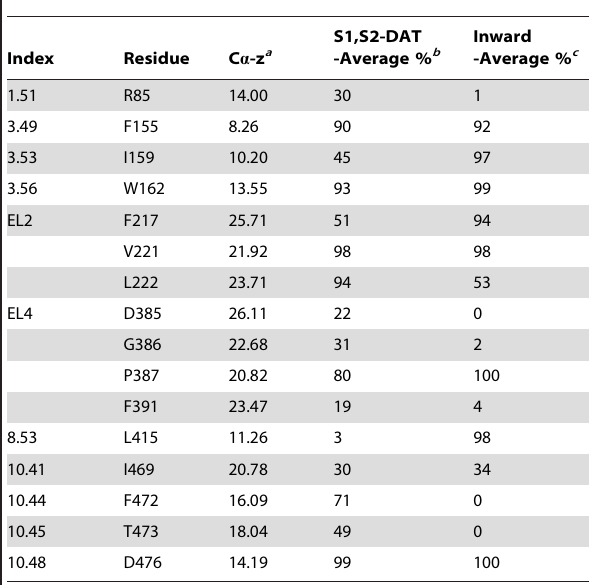
a as in Table1. b The percentage of time spent by the residue within 3.5 A˚ of DA (see Methods) during the 6–25 ns of equilibration of the S1,S2-DAT model. c The percentage of time spent by the residue within 3.5 A˚ of DA during the